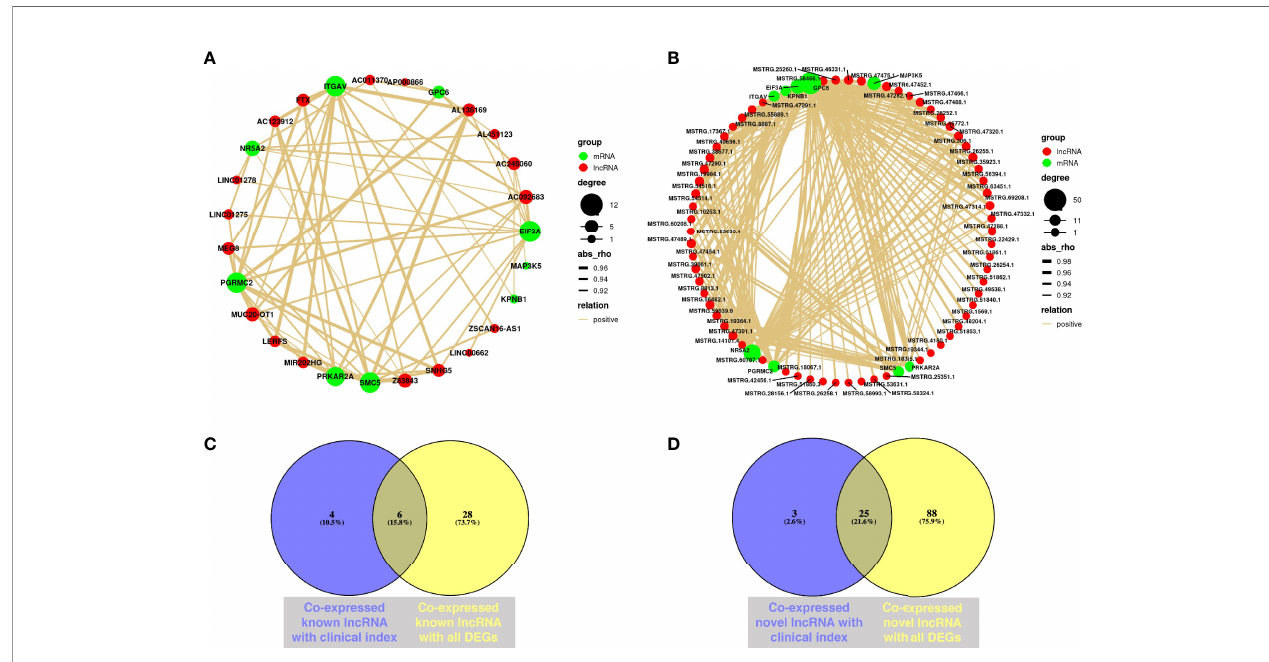
FIGURE 6 | Co-expression analysis of mRNA and lncRNA. (A) Co-expression network from validated DEGs and known lncRNAs through WGCNA; Cytoscape was used to visualize the network diagram (|correlation coef fi cient| > 0.9, p < 0.05). (B) Co-expression network from validated DEGs and novel lncRNAs through WGCNA; Cytoscape was used to visualize the network diagram (|correlation coef fi cient| > 0.9, p < 0.05). (C) Venn diagram of co-expressed known lncRNAs with clinical characteristics and validated DEGs. Purple circle represents co-expressed known lncRNA with clinical characteristics, while yellow circle means co-expressed known lncRNA with all validated DEGs (|correlation coef fi cient| > 0.5, p < 0.05). (D) Venn diagram of co-expressed novel lncRNAs with clinical characteristics and validated DEGs. Purple circle represents co-expressed novel lncRNA with clinical characteristics, while yellow circle means co-expressed novel lncRNA with all validated DEGs (|correlation coef fi cient| > 0.5, p < 0.05) ( N MF = 6, N OEM =